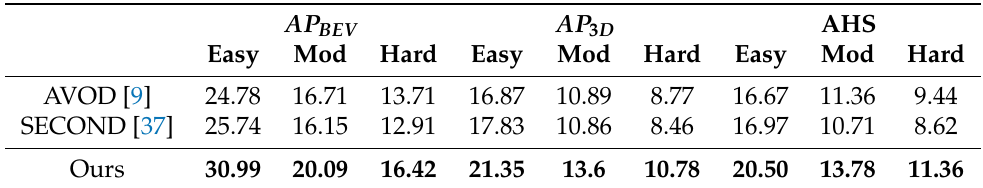
Table 7. The comparison of the AP 40 and the AHS among our angle loss function, the angle loss function of M3D-RPN and the angle loss function of FCOS3D on the Bird’s Eye View object detection task and 3D object detection task on the KITTI validation set. We use bold type to indicate the best